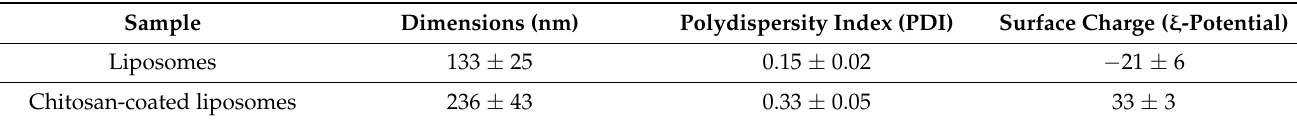
Table 1. Dimensions, polydispersity index (PDI), and surface charge ( ξ -potential) values of liposomes and chitosan-coated liposomes (all of them reported as medium value ± SD of three